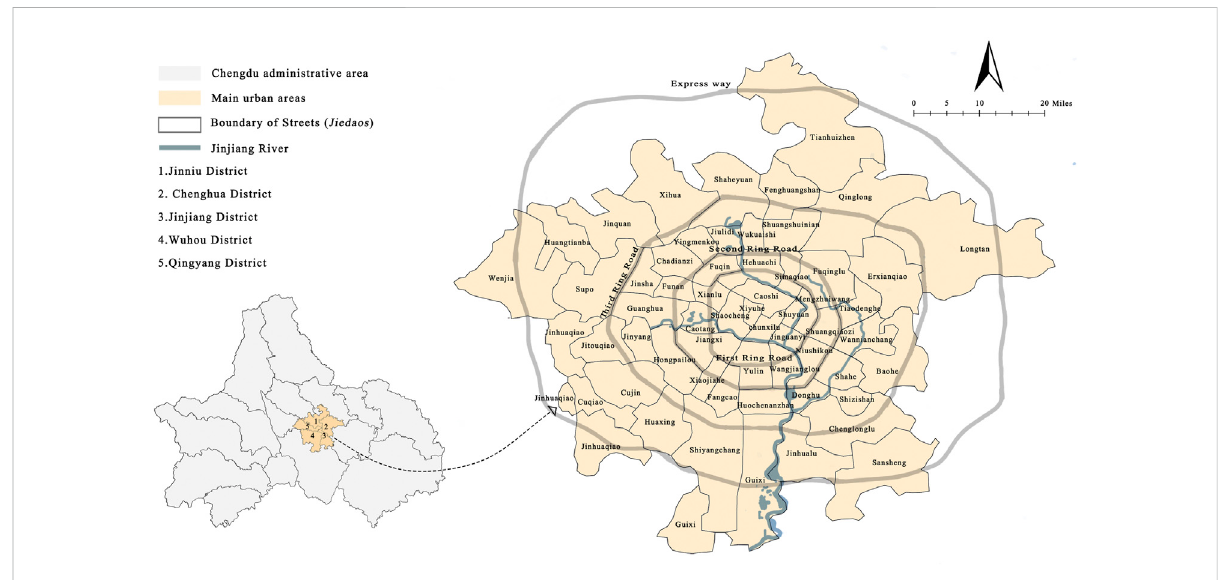
FIGURE 1 The fi ve main urban districts and the Streets ( jiedaos ) of